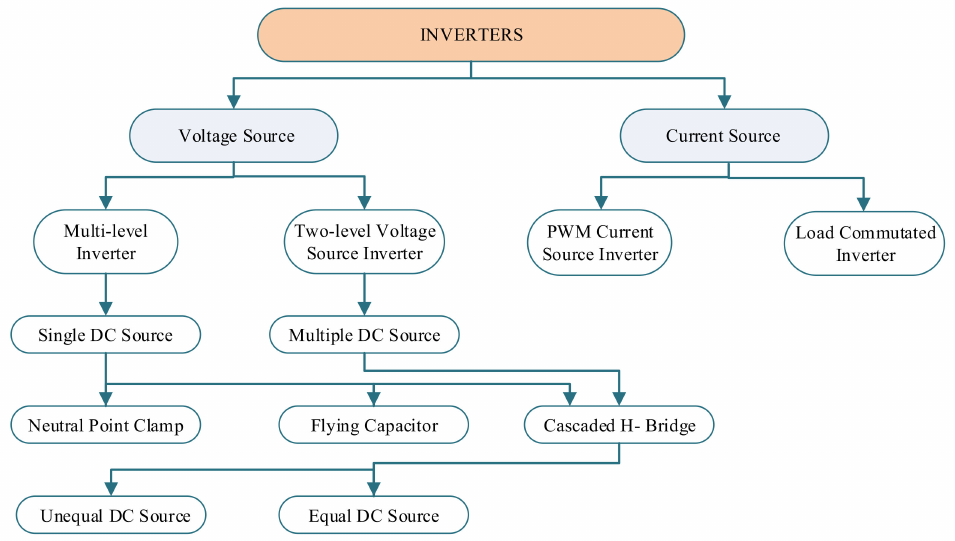
Figure 1. Classification of multilevel inverters.